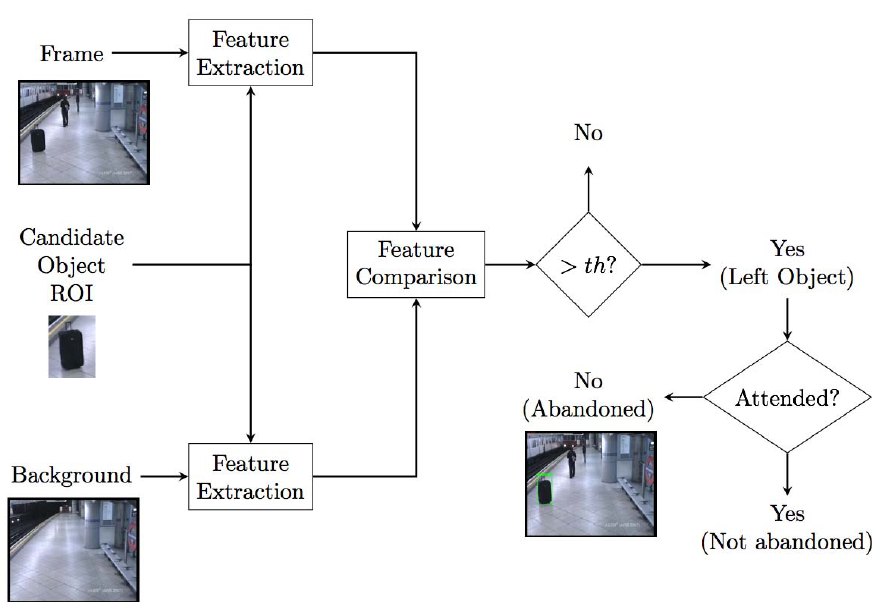
Figure 7. Block diagram of candidate validation module. In simple terms, for each candidate, its region of interest is extracted, and certain features are extracted comparing them with the background and current frame. Through this comparison, false objects are discarded. Finally it is checked if the object is